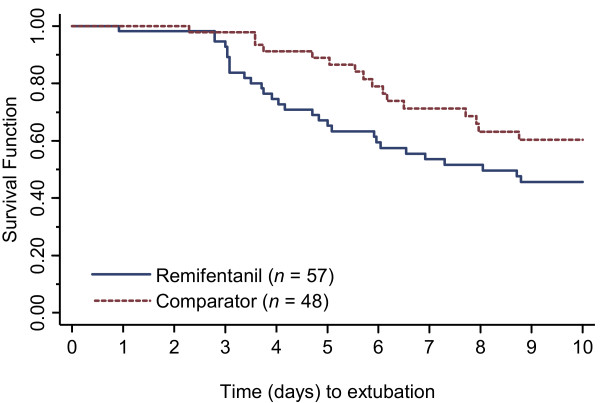
Kaplan–Meier survival plot of time to extubation (days).